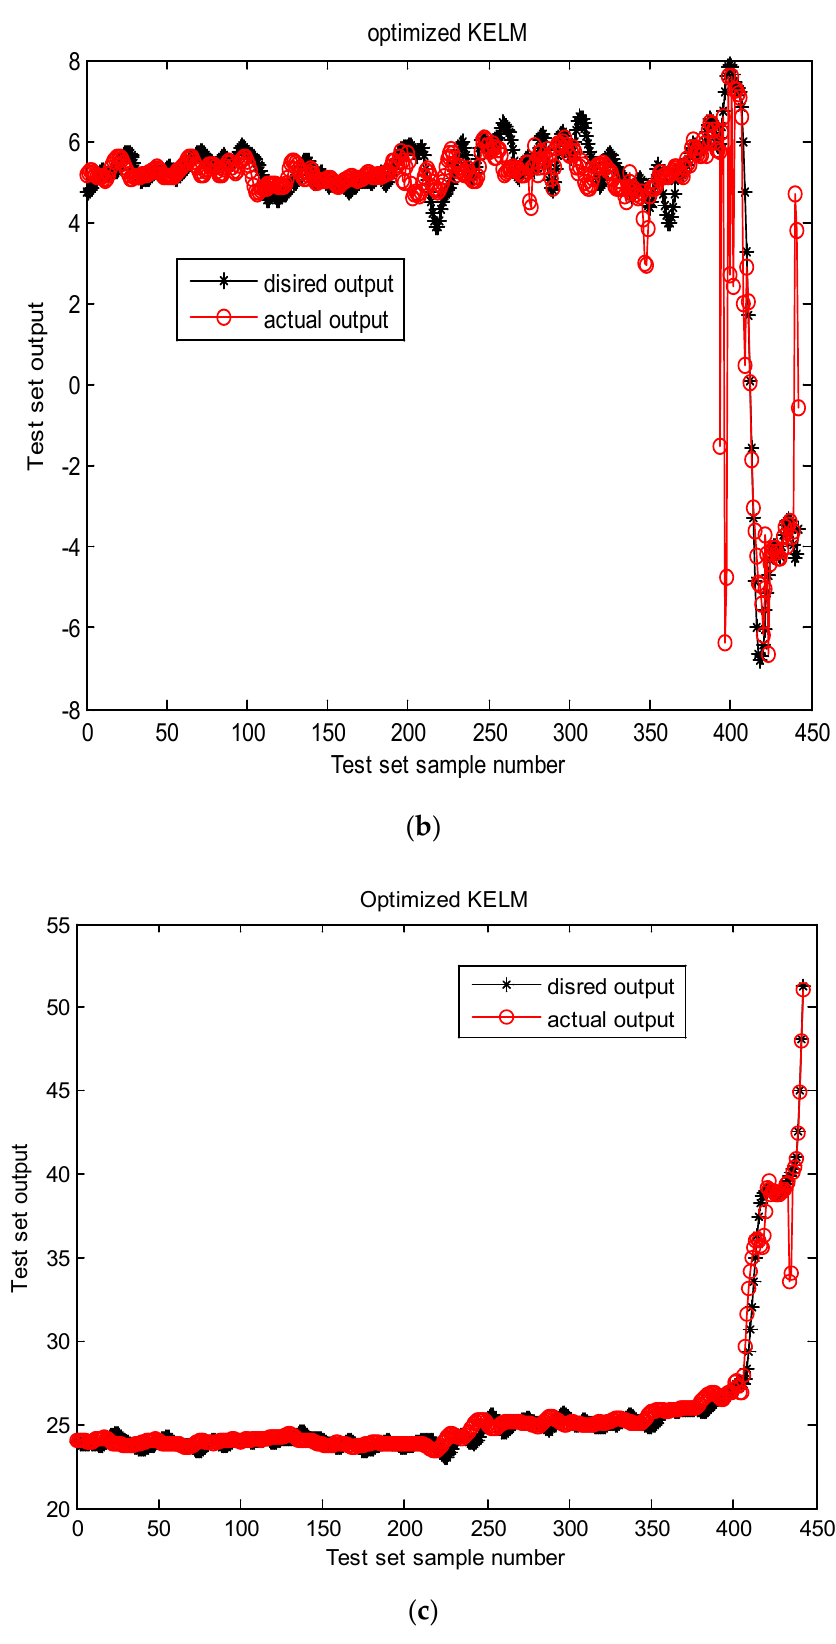
Figure 7. Actual outputs and prediction outputs in working condition 1. ( a ) phase space; ( b ) wavelet packet space; ( c ) EEMD space.